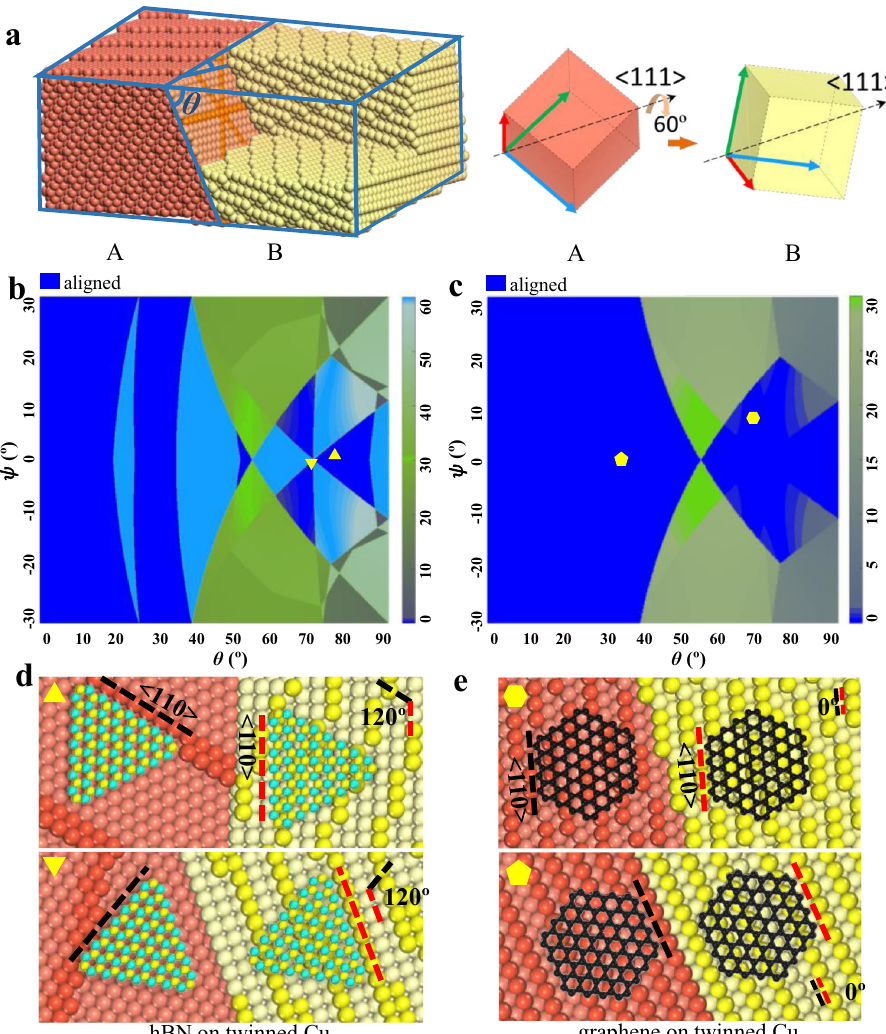
Fig. 1 2D materials alignment on twinned Cu substrates. a Atomic con fi guration of a 60° <1 1 1> twin in a Cu foil and the de fi nition of the two degrees of freedom, ( θ , ψ ), of the twin structure. Where θ is the angle between the Cu foil surface and the twin boundary and ψ is the in-plan rotation angle of the twin plane. The crystal axials of the two crystal lattices on both sides of the twin boundary (A and B) and their <1 1 1> co-axis is also shown. b Theoretical map of the misalignment angles between 3-fold symmetric 2D materials grown on the two sides of FCC twins as a function of ( θ , ψ ), which de fi ne the facet indices of the twinned surface. Colour bar shows the misaligned angles between 2D materials grown on twinned crystal surfaces and blue indicates perfect alignments. c Theoretical map of the misalignment angles between 6-fold symmetric 2D materials, such as graphene, grown on both sides of FCC twins as a function of ( θ , ψ ). Colour bar shows the misaligned angles of 2D islands grown on the twinned crystals and blue denotes perfect alignment. We can clearly see that the unidirectional alignment of 2D materials with either 3-fold or 6-fold symmetry can be realized on a large number of twinned FCC crystals. So, in principle, this should allow us to use a variety of twinned substrates to grow 2D single crystals. d Schematic diagram of hBN epitaxy on twinned Cu substrates, Cu atoms of step edges are highlighted. The alignment directions of hBN islands are denoted by dashed lines. e Schematic diagram of graphene epitaxy on twinned Cu substrates, Cu atoms of step edges are highlighted. The alignment directions of graphene islands are denoted by dashed